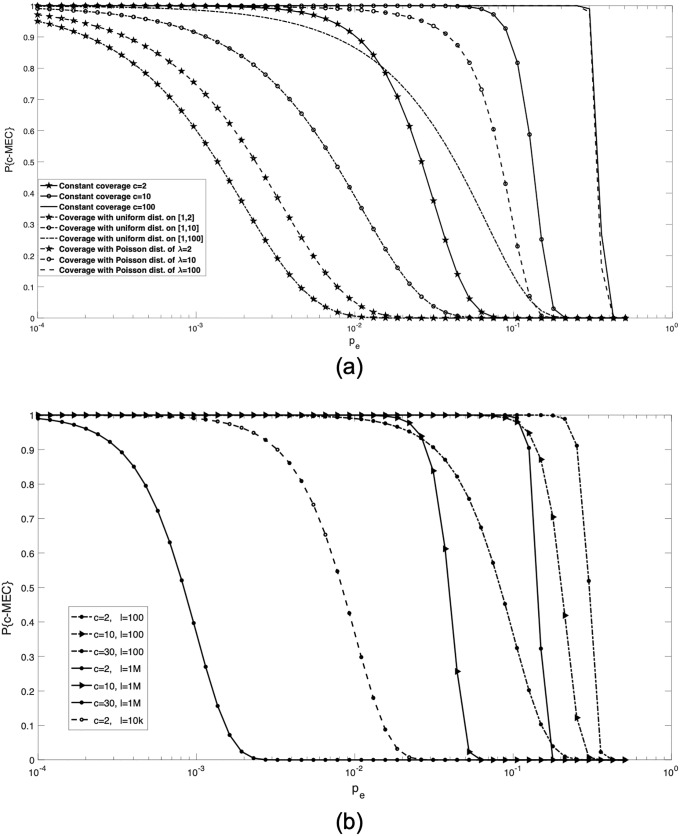
Performance curves of MEC approach.a: Comparison of P{c- MEC} for different coverage levels (constant c = {2, 10, 100}, quasi-uniform over c = {[1, 2], [1, 10], [1, 100]} and Poisson distribution with mean λ = {2, 10, 100}). b: Comparison of P{c- MEC} for different haplotype lengths l = {100, 10k, 1M} and different coverage values c = {2, 10, 30}.